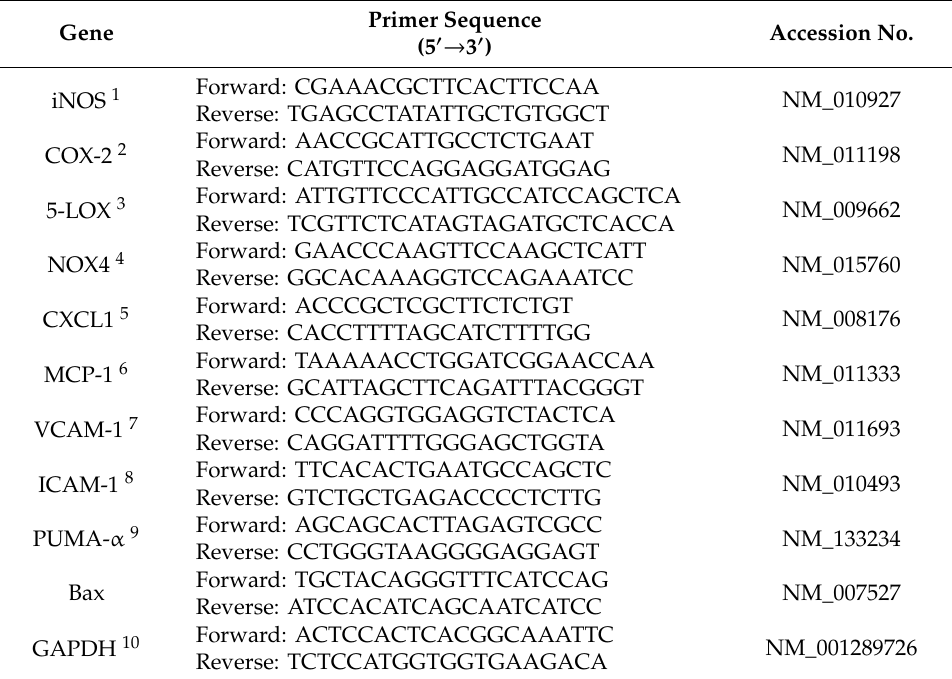
Table 1. Primers used for real-time RT-PCR in this